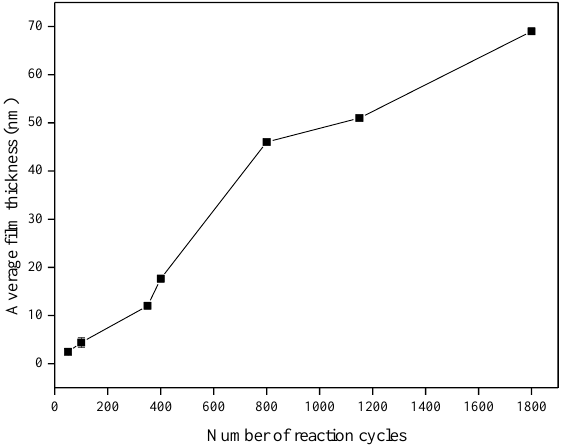
Figure 5. Experimental setup used for gas sensing performance evaluation. Real time acquiring Figure 6. Increase in TiO 2 film thickness with number of reaction cycles. electrical resistance and current data. Figure 6. Increase in TiO 2 film thickness with number of reaction cycles.